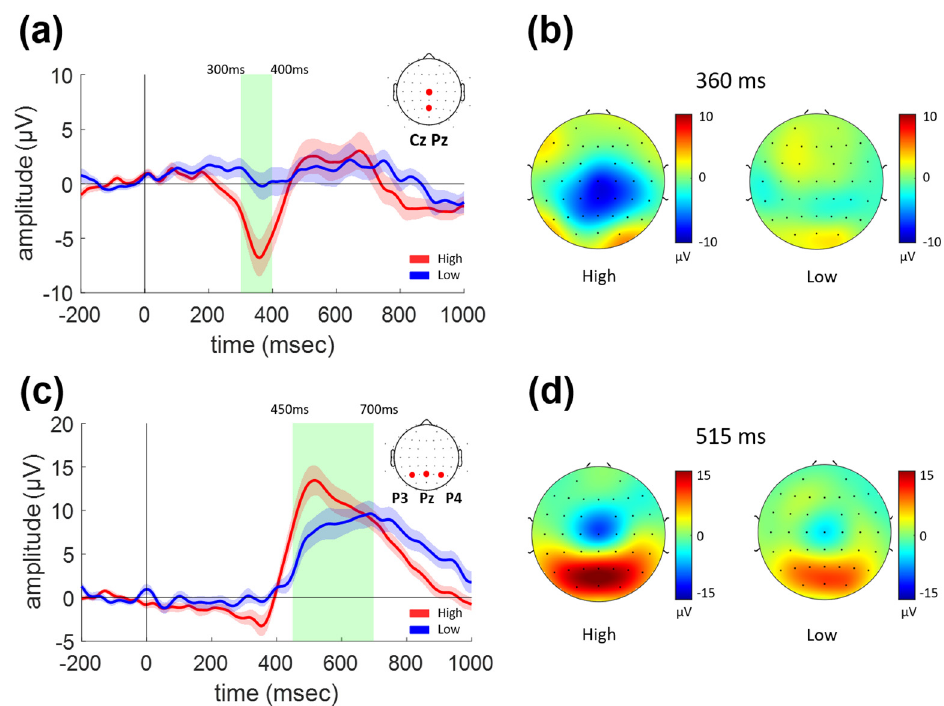
Figure 4. The grand-average ERP waveforms and topographical distributions for lane departure task. ( a ) The grand-average ERP waveforms for Cz and Pz electrodes. ( b ) Topographical distributions of ERP at 360 ms. ( c ) The grand-average ERP waveforms for P3, Pz, and P4 electrodes. ( d ) Topographical distributions of ERP at 515 ms.